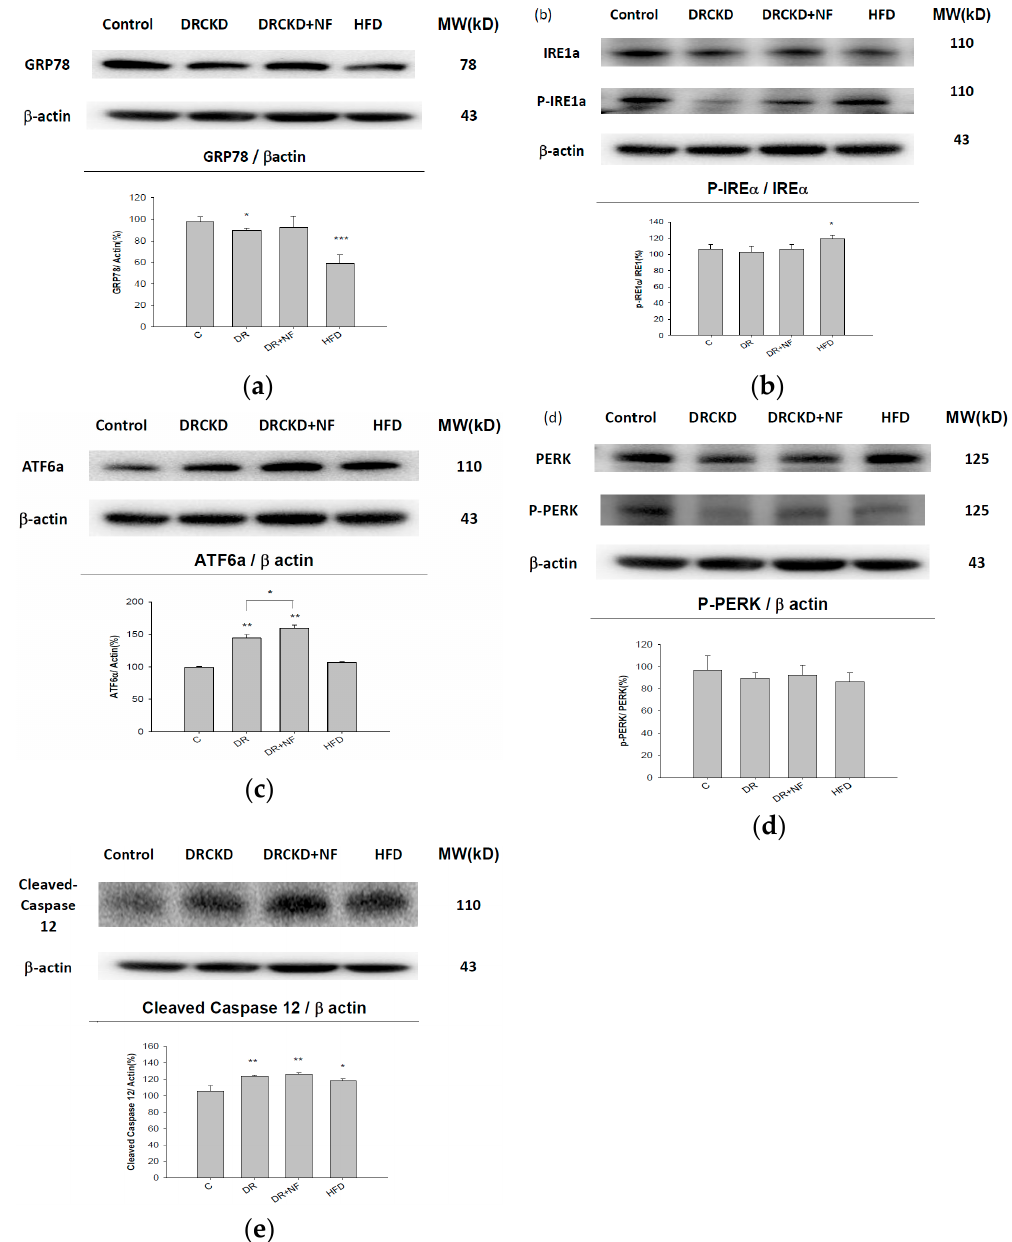
Figure 3. Representative Western blot and quantification of unfolded protein response (UPR)-endoplasmic reticular (ER) stress-related proteins in kidney tissues of rats with doxorubicin (DR)-induced chronic kidney disease. ( a ) Glucose-regulating protein, 78 kDa (GRP78), ( b ) inositol-requiring enzyme 1 α (IRE1 α ), phosphorylated (p)-IRE1 α , ( c ) activating transcription factor 6 α (ATF6 α ), ( d ) protein kinase RNA-like ER kinase (PERK), p-PERK, and ( e ) cleaved caspase-12. β -actin was used as an internal protein control. Animal groups were treated with control (C), doxorubicin (DR), and DR and nifedipine (DR + NF), and fed a high-fat diet (HFD) * P < 0.1, ** P < 0.05, *** P < 0.01 compared to control group; # P < 0.1 compared to DR group ( n = 3).